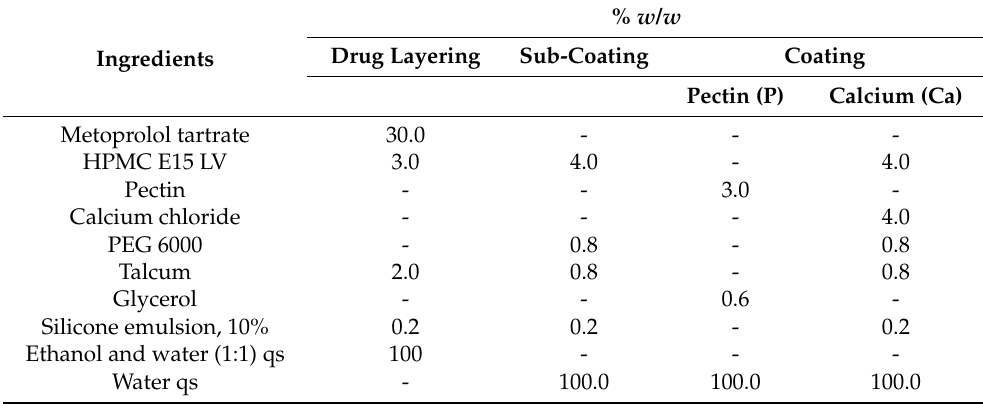
Table 1. Formulations of the metoprolot tartrate solution, sub-coating, pectin coating (P), and calcium coating (Ca).